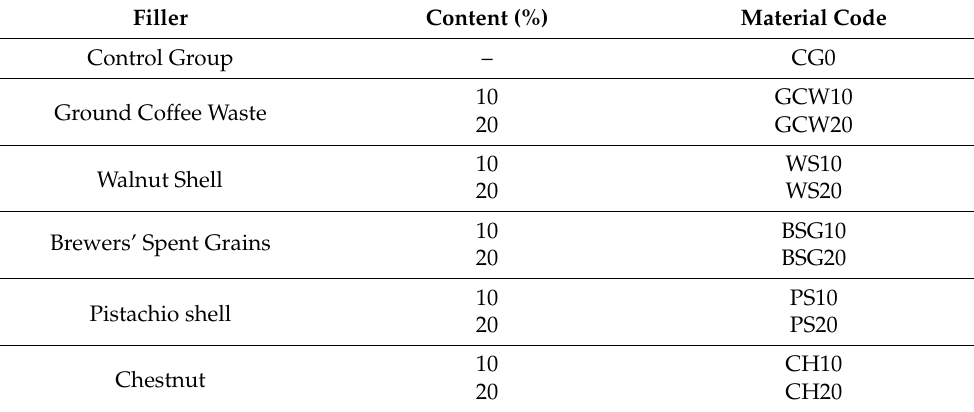
Table 3. Mass concentration of the organic